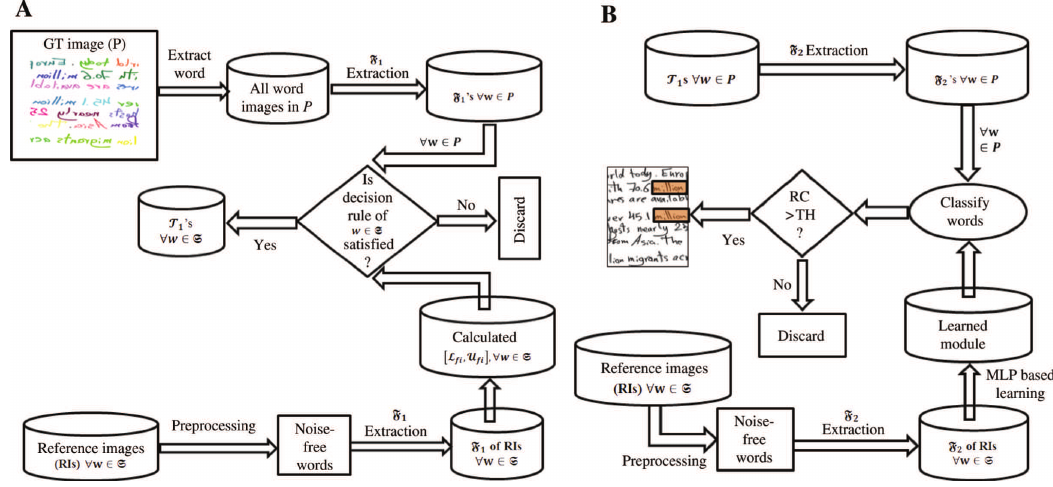
Figure 5: Schematic